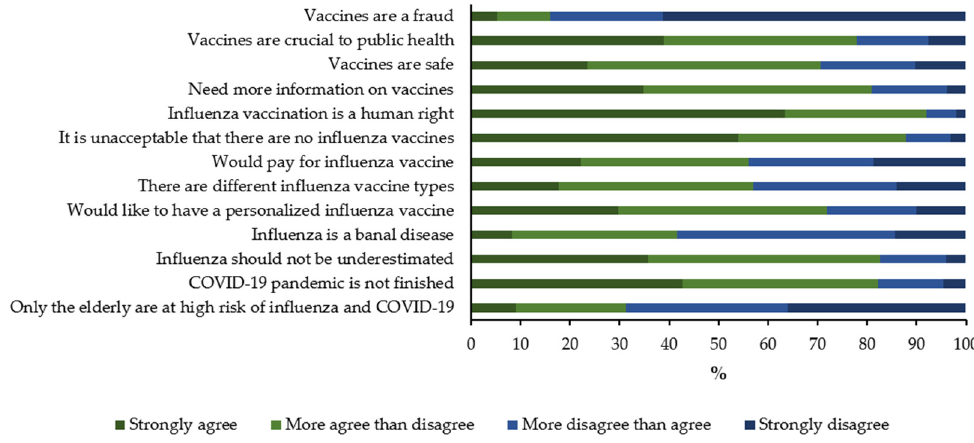
Figure 1. Knowledge, attitudes, and practices on influenza and/or vaccination. Complete wording of the items is reported in Supplementary Table S1. Coronavirus disease 2019, COVID-19.